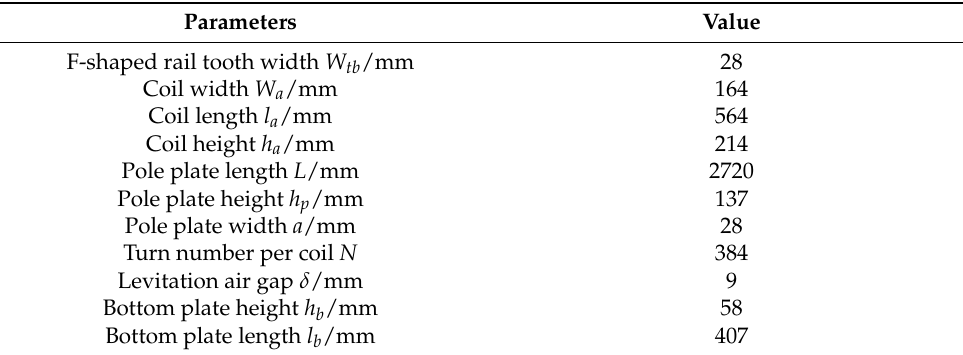
Figure 2. 3D model of one electromagnet module: ( a ) 3D diagram; ( b ) geometry parameter diagram. Table 1. Main Geometry Parameters of Electromagnet